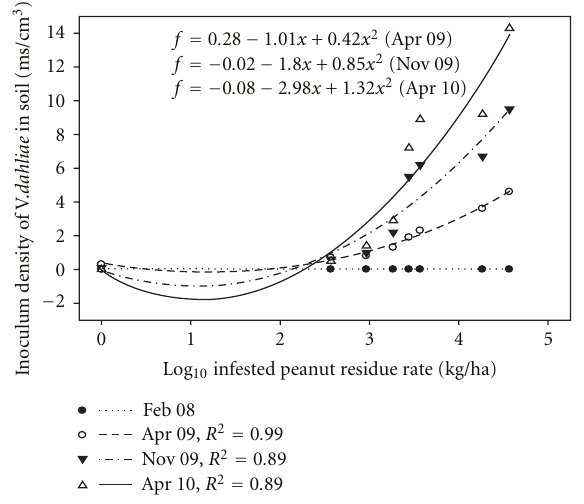
Figure 1: E ff ect of infested peanut residue rates on inoculum density of Verticillium dahliae in soil (microsclerotia/cm 3 ). Infested peanut residue rates 0, 370, 925, 1850, 2775, 3700, 18495, and 37000 kg/ha were log 10 transformed and were expressed as 0, 2.6, 3.0, 3.3, 3.4, 3.6, 4.3, and 4.6 on X -axis. Soil samples collected in February 2008 were void of V. dahliae inoculum prior to artificial incorporation of infested peanut residue. Linear quadratic equation f = y 0 + ax + bx 2 was used to calculate intercept ( y 0 ), slope (a) and curvature (b).